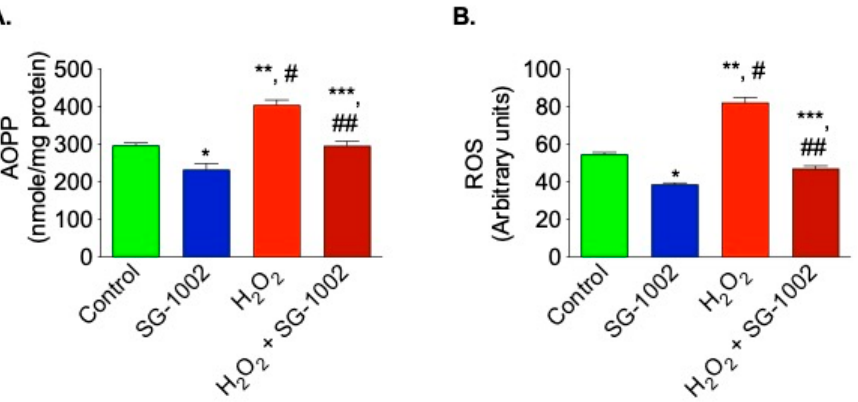
Figure 3. Reduction of oxidative stress in HL-1 cells by SG-1002. Oxidative stress was measured by determining the levels of AOPP ( A ) and ROS ( B ) in cultured HL-1 cells after tread with specific reagents as described in Materials and Methods. The experiment was repeated at least three times to verify the reproducibility. *, and **, p < 0.05 vs. control; #, p < 0.05 SG-1002 vs. H 2 O 2 ; ##, p < 0.05 H 2 O 2 vs. SG-1002 + H 2 O 2 ; ***, p < 0.05 SG-1002 vs. SG-1002 + H 2 O 2 (Anova) (n =